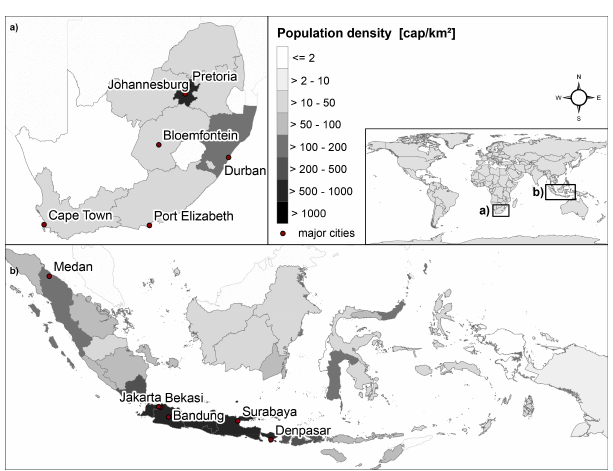
Figure 2. Regional population densities and major cities of the ex- ample countries (a) South Africa and (b) Indonesia and their loca- tion on the world